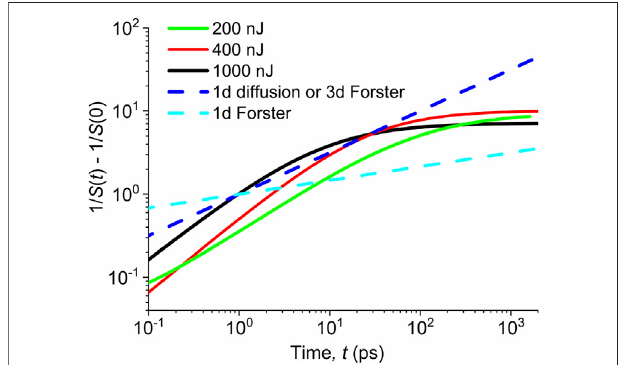
FIGURE 3 | Solid lines — evolution of the inverse of the singlet exciton population estimated from the TA data measured with various pump fl uences indicated in the legend. Dashed lines — power-law pro fi les of the exciton – exciton annihilation controlled by either 1d diffusion with the time-independent diffusion coef fi cient or 3d Förster transfer (light blue) or 1d Förster transfer (dark blue). The initial singlet populations are normalized to unity (independent on the pre-factors in Eqs 5 , 6 ) for all pump fl